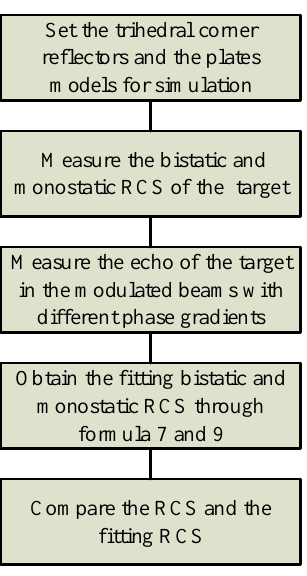
Figure 3. The simulation